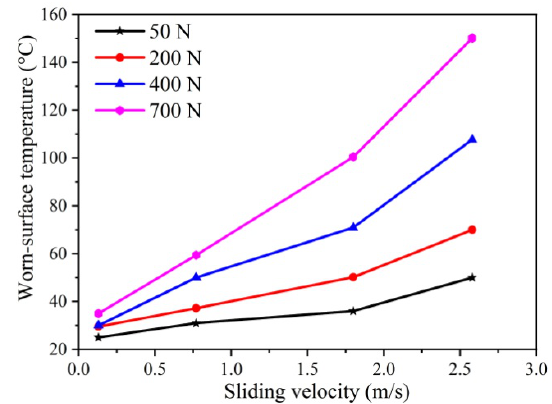
Fig. 8 Worn-surface temperature of Cu–15Ni–8Sn–0.8Nb alloy under different normal loads and sliding velocities after wear